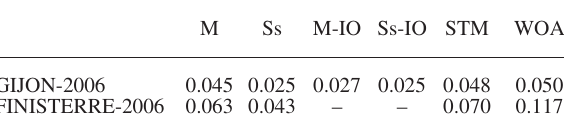
Table 4. – Depth-averaged rms of the difference between measured and estimated Salinity for the six cases considered.